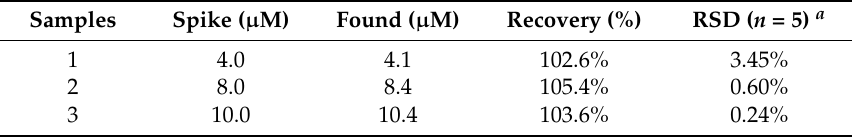
Table 3. The determination of ethoprophos in tap water samples based on this